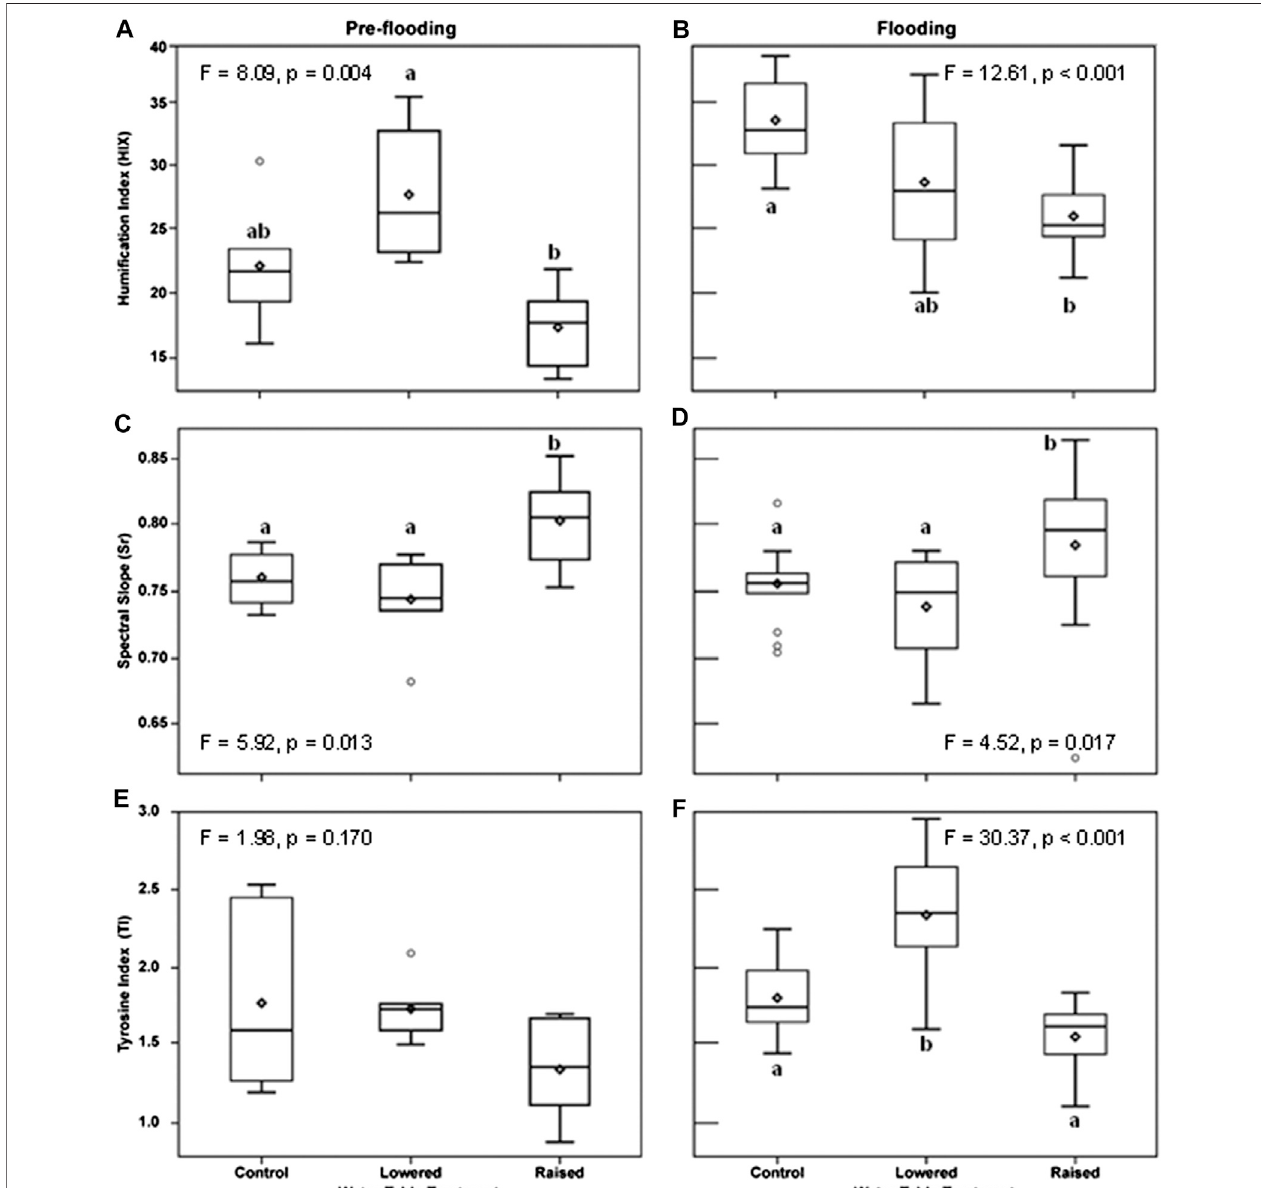
FIGURE 4 | Indexes of peat pore water (20 cm into the peat) character before fl ooding in 2016 (A,C,E) and after continuous fl ooding, measured in 2018 (B,D,F) . Depictedareseasonalmeansbywatertabletreatmentplot.AnindexofDOMhumi fi cation(HIX)washigherinthe fl oodedyear(b,F (cid:2) 44.09, p < 0.001),andtherewasayear × treatmentinteraction(F (cid:2) 8.84, p < 0.001).AninverseindexofDOMbioavailabiltyandmolecularsize(SpectralSlopeRatio,Sr)didnotvarybyyear(F (cid:2) 0.15, p (cid:2) 0.70),butwas higher in the raised treatment (C,D) . An index of peat pore water free or bound protein (TI) was higher in the fl ooded year (F (cid:2) 17.67, p < 0.001), and the lowered treatment was higher than the raised treatment (F) . Letters indicate signi fi cant differences in post-hoc comparisons of means within a treatment year ( fl ood